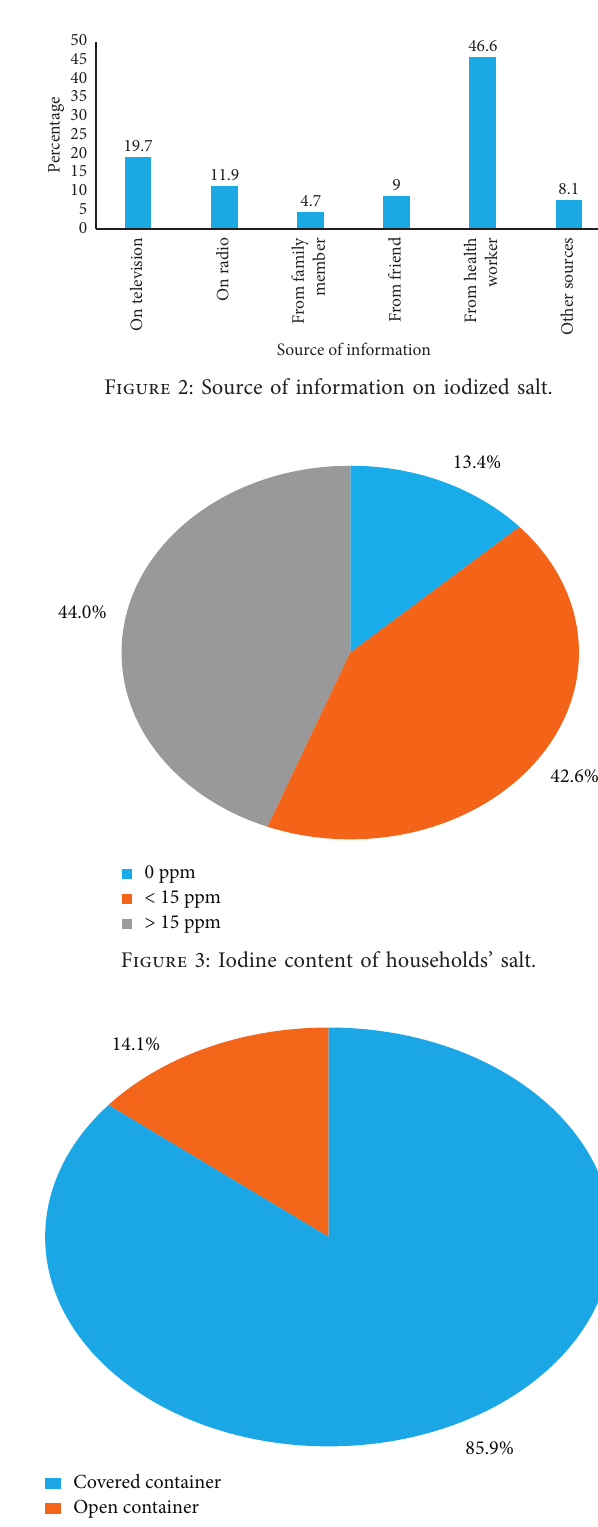
Figure 4: Household salt storage